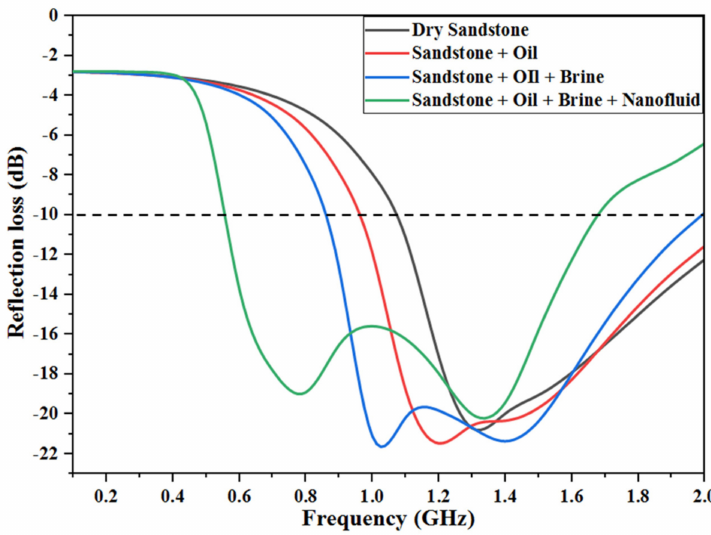
Figure 8. Antenna return loss (dB) at di ff erent operating frequencies in di ff erent formation fluid saturations.